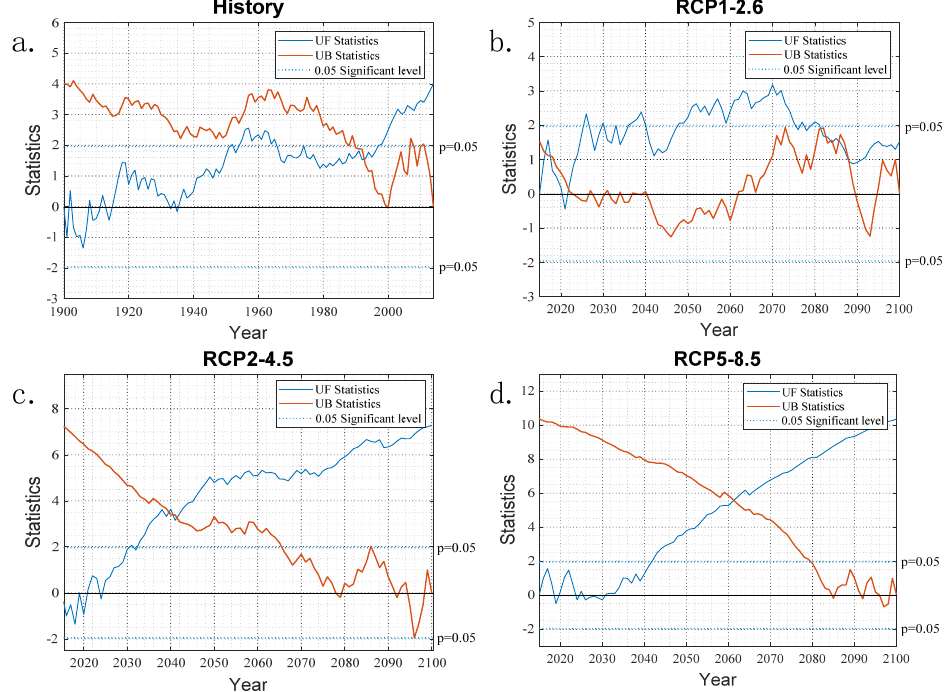
Figure 4. Dianchi Lake MK mutation test, where ( a ) represents the result of the MK mutation test for the lake surface water temperature in the historical period (1990–2014), ( b ) represents the lake surface water temperature MK mutation test result under the scenario model RCP1-2.6 (2015–2100), ( c ) indicates the MK mutation test result for the lake surface water temperature under the scenario model RCP2-4.5 (2015–2100), and ( d ) represents the MK mutation test result for the lake surface water temperature under the scenario model RCP5-8.5 (2015–2100).